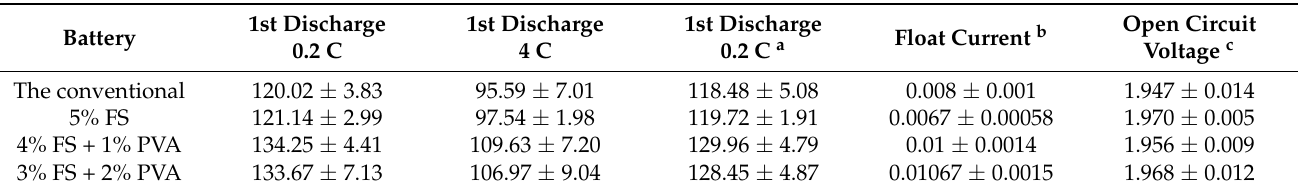
Table 3. Rate capability (mAh · g − 1 ), float current (mA · cm − 2 ), and open-circuit voltage (V) of the conventional (ref) and gel batteries.